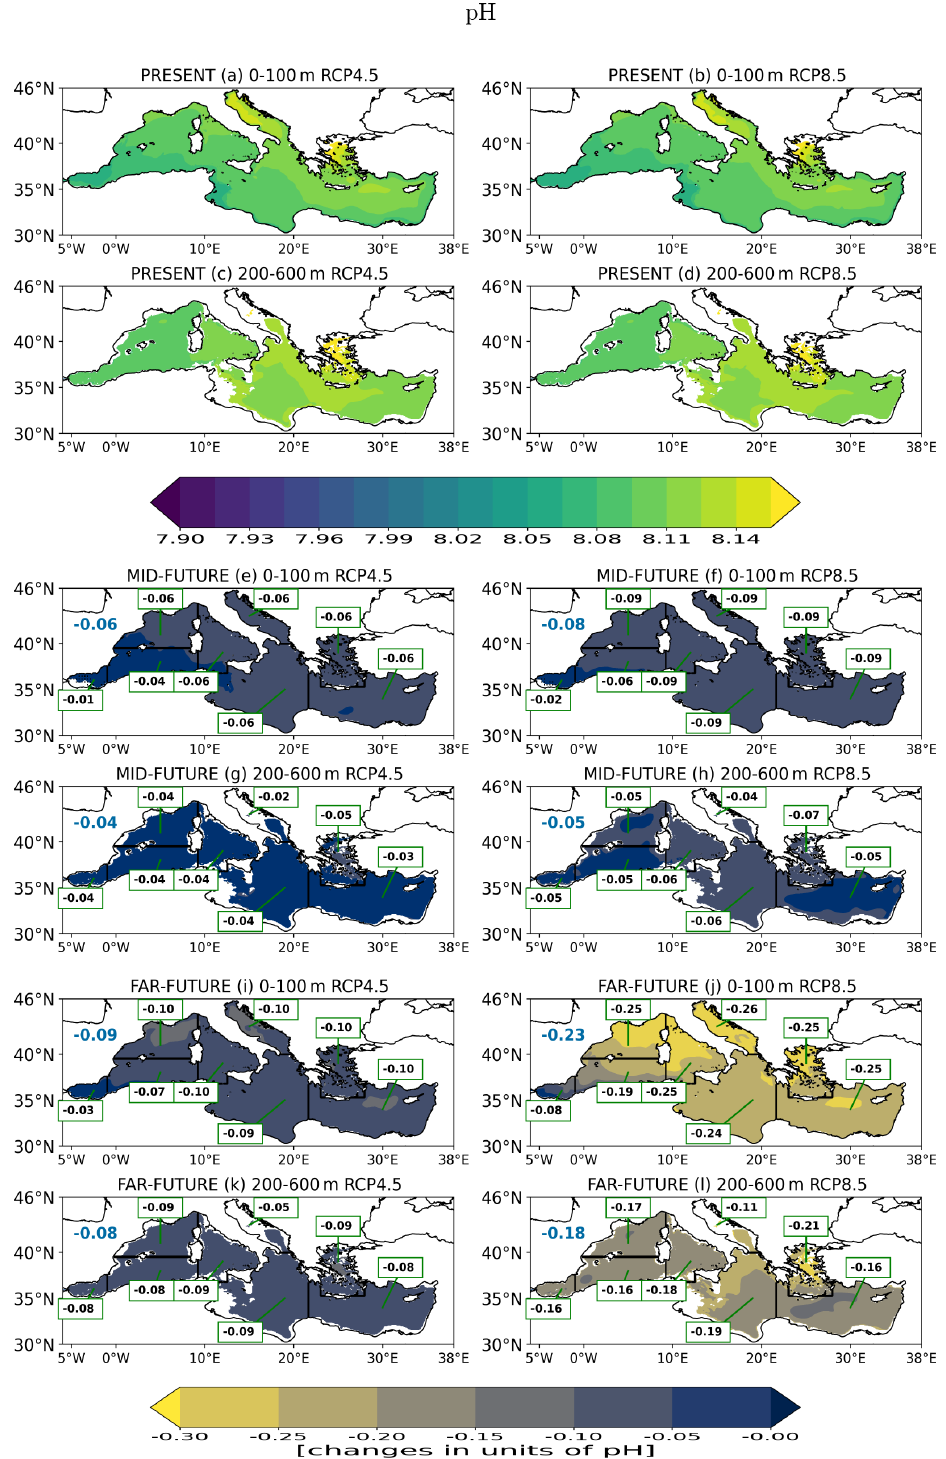
Figure 18. pH in the 0–100 and 200–600m layers in the PRESENT (2005–2020, a , b , c and d ) and relative climate change signals (with respect to the PRESENT, in units of pH) in the MID-FUTURE (2040–2059, e , f , g and h ) and the FAR-FUTURE (2080–2099, i , j , k and l ) in the RCP4.5 ( a , c , e , g , i , and k ) and RCP8.5 ( b , d , f , h , j and l ) scenarios. The Mediterranean average relative climate change signal in each period (with respect to the PRESENT) is displayed as a colored value (blue or dark orange when negative or positive, respectively) in the top left of each subfigure. Values in green boxes are the average relative climate change signals for particular periods and sub-basins shown in Fig. 1. Domain grid points where the relative climate change signals are not statistically significant according to a Mann–Whitney test with p< 0 . 05 are marked by a